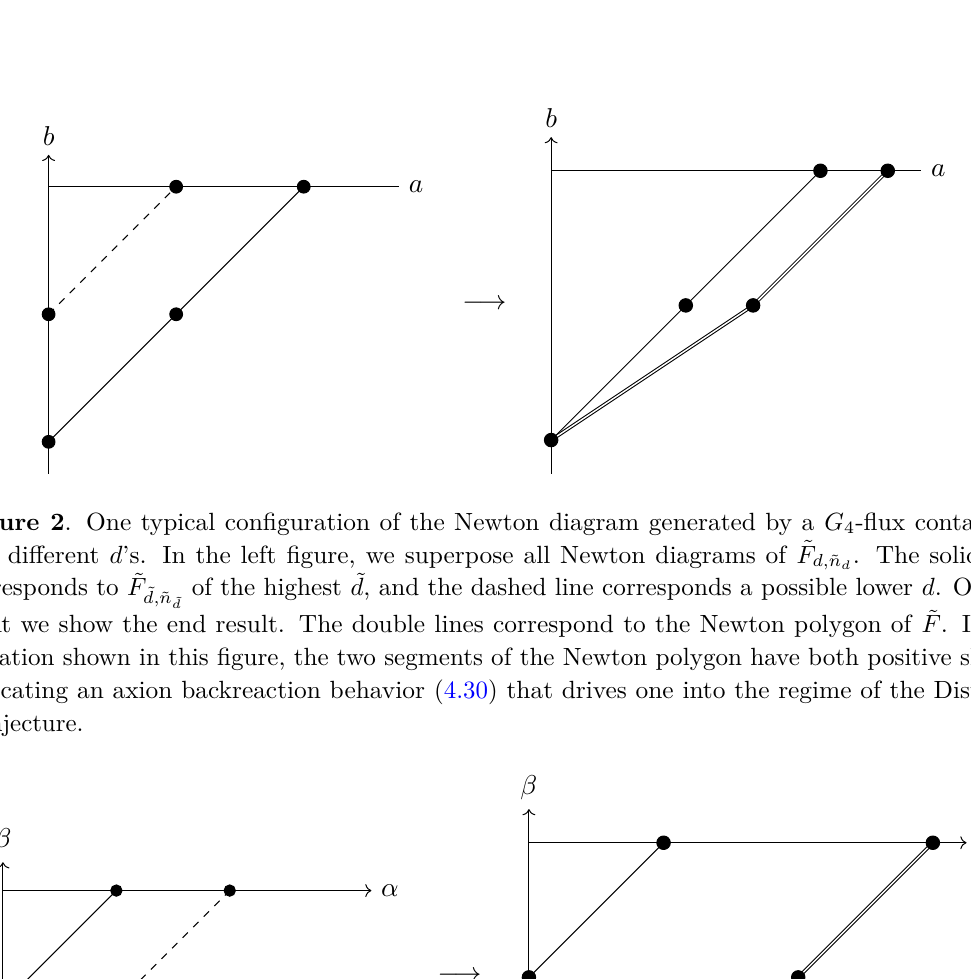
. The solid line d